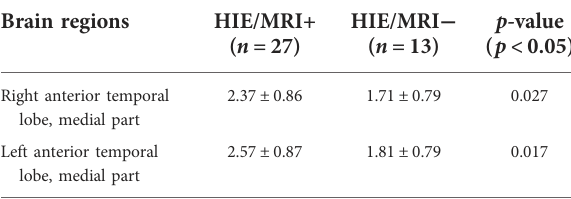
TABLE 5 Brain regions with signi fi cant APT signal intensity differences between the HIE/MRI − and HIE/MRI+ groups. Brain regions